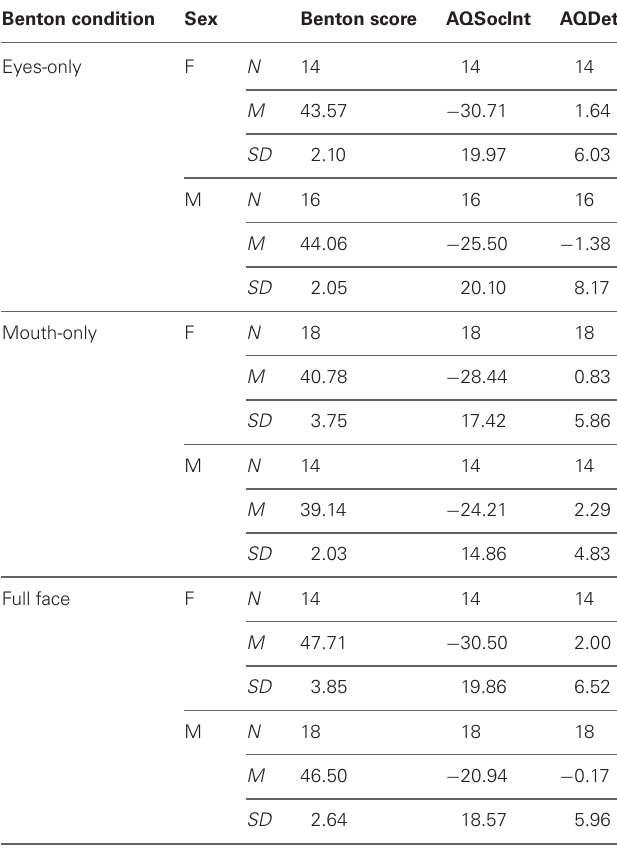
Table 1 | Summary of means and standard deviations, by Benton Test condition and